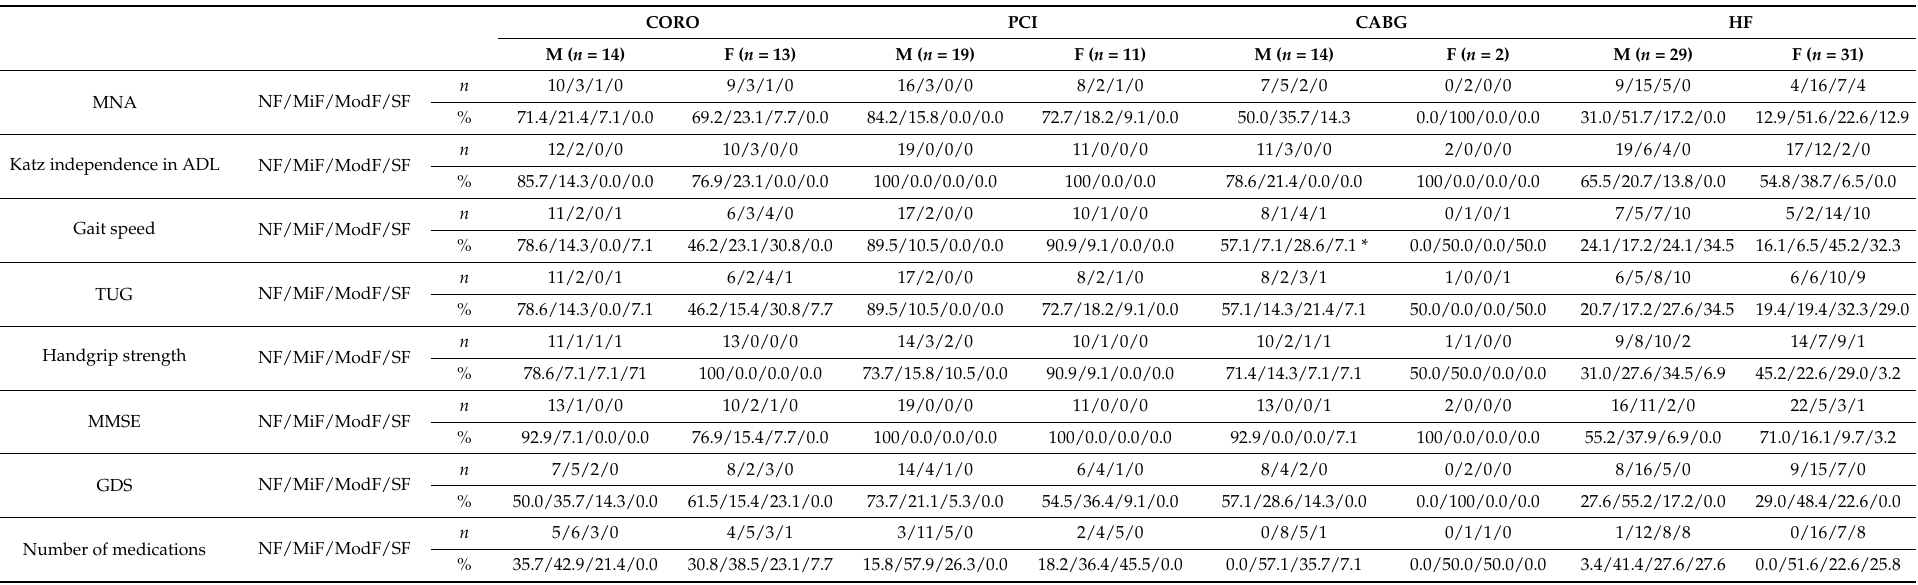
Table 3. Frailty assessment using Vigorito et al.’s